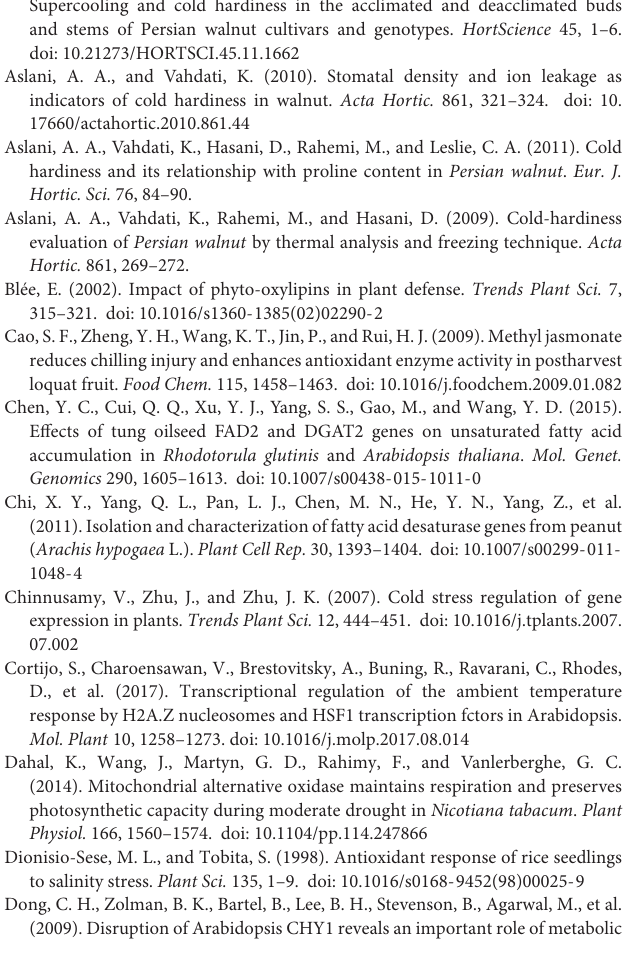
Supplementary Table 1 | Oligonucleotides used for qRT-RCR verification. Supplementary Table 2 | Total variance explained in PCA. Supplementary Table 3 | Component matrix a in PCA. Supplementary Table 4 | Distribution of principal components PC1 and PC2. Supplementary Table 5 | CmoDEGs in leaves of pumpkin seedlings under chilling stress. Supplementary Table 6 | CmoDEGs in roots of pumpkin seedlings under chilling stress.